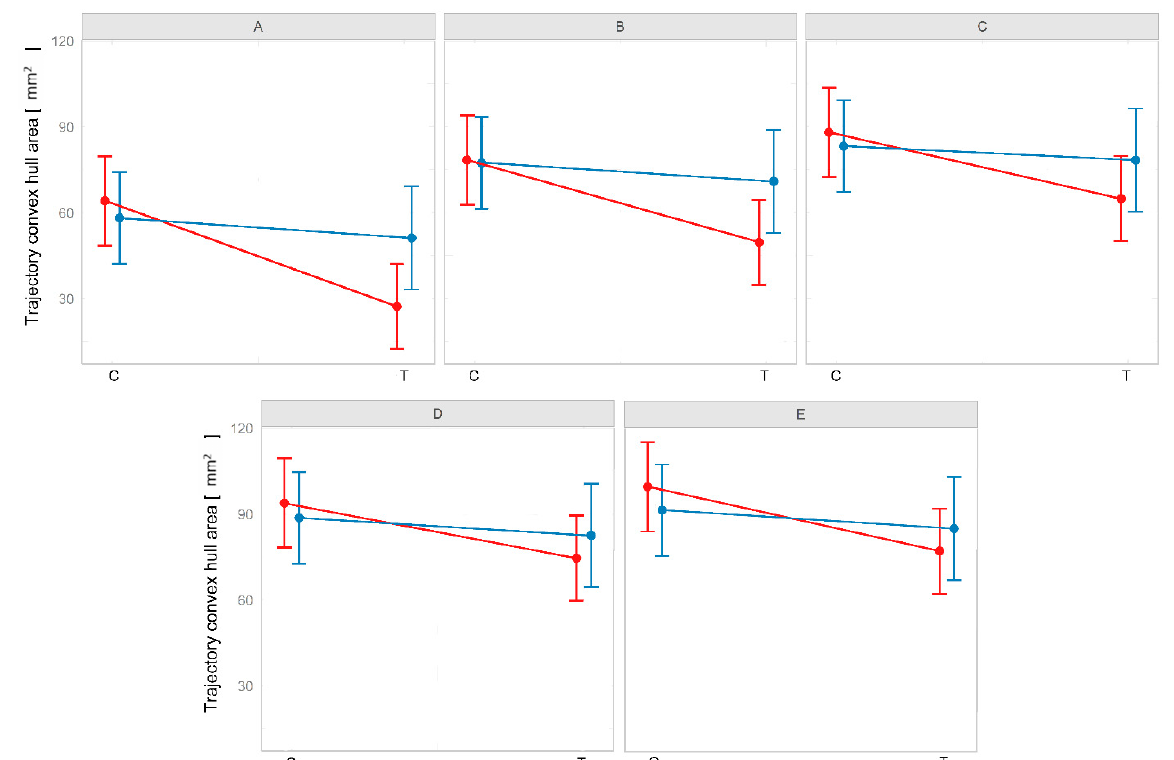
Figure 3. CH value interaction plot for each level of Factor 1 (Time, ( A ) = one minute of recording; ( B ) = two minutes of recording; ( C ) = three minutes of recording; ( D ) = four minutes of recording; ( E ) = five minutes of recording. Red = females; Blue = males (mean ± SD; n = 20).